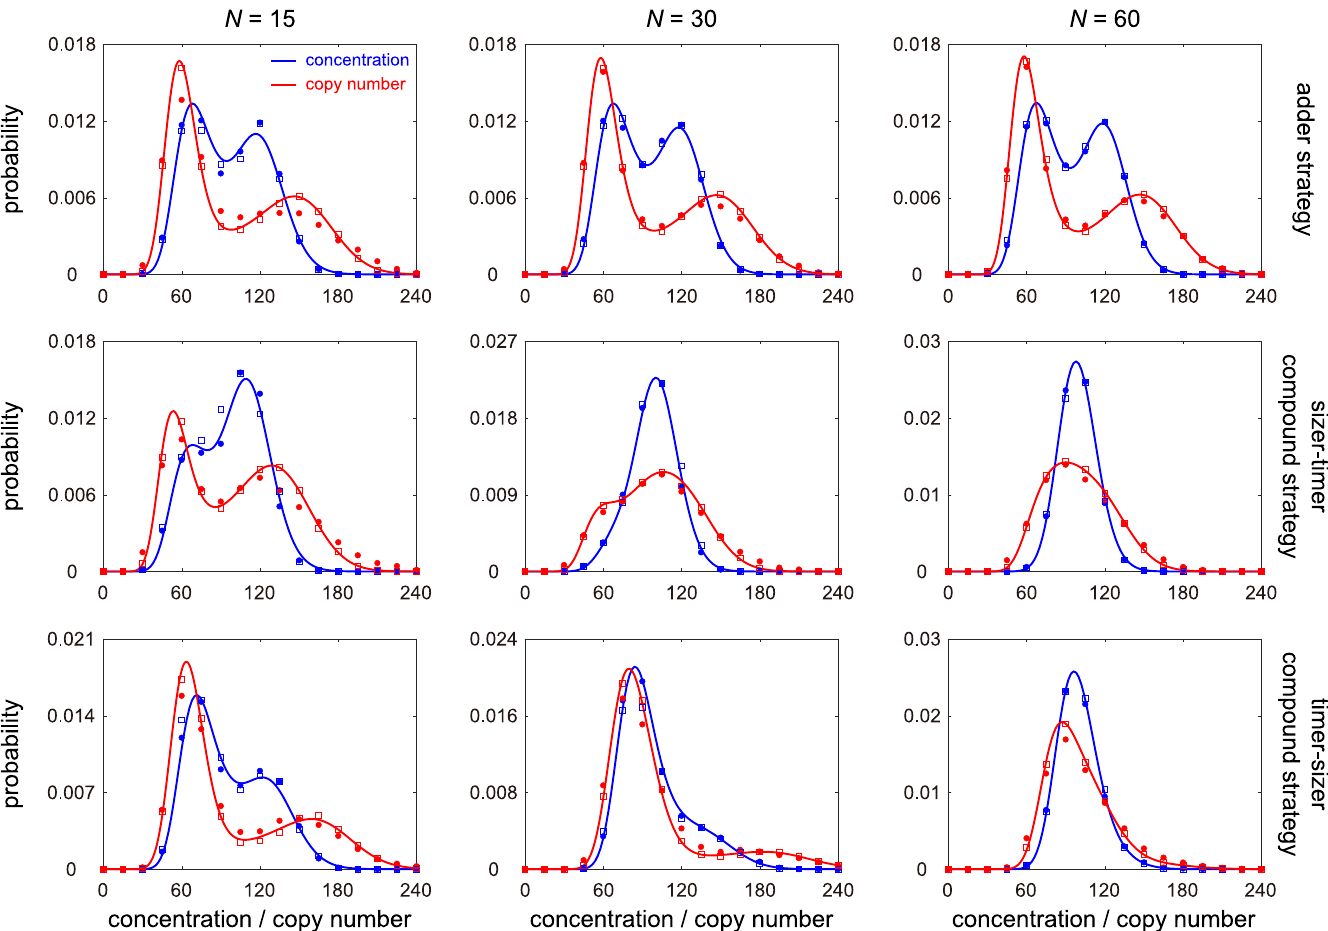
Fig 3. Comparison between the full and mean-field models under different choices of N and different size control strategies. The blue (red) dots show the simulated concentration (copy number) distribution for the full model obtained from the stochastic simulation algorithm (SSA). The blue (red) squares show the simulated concentration (copy number) distribution for the mean-field model obtained from SSA. The blue (red) curve shows the analytical approximate concentration (copy number) distribution given in Eq (8) (Eq (15)). The full and mean-field models are in good agreement when N � 15 and they become almost indistinguishable when N � 30. Moreover, the analytical solution performs well when N � 15 and perform excellently when N � 30. The model parameters are chosen as N 0 = 0.4 N , B = 1, β = 0, κ = 2, d = 1, η = 10, where η = d / f is the ratio of the degradation rate to cell cycle frequency. The growth rate g is determined so that f = 0.1. The parameters ρ and a are chosen so that the mean gene product number h n i = 100 and the mean cell volume h V i = 1. The strengths of size control are chosen as α 0 = α 1 = 1 for the upper panel, α 0 = 2, α 1 = 0.5 for the middle panel, and α 0 = 0.5, α 1 = 2 for the lower panel. When performing SSA, the maximum simulation time for each lineage is chosen to be 10 5 . To deal with the time-dependent propensities in the full model, we use the numerical algorithm described in [85, Sec. 5].